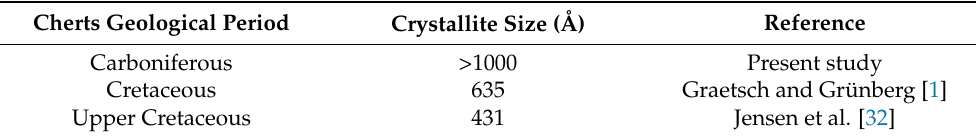
Table 5. Relationship between crystallite size and geological period of